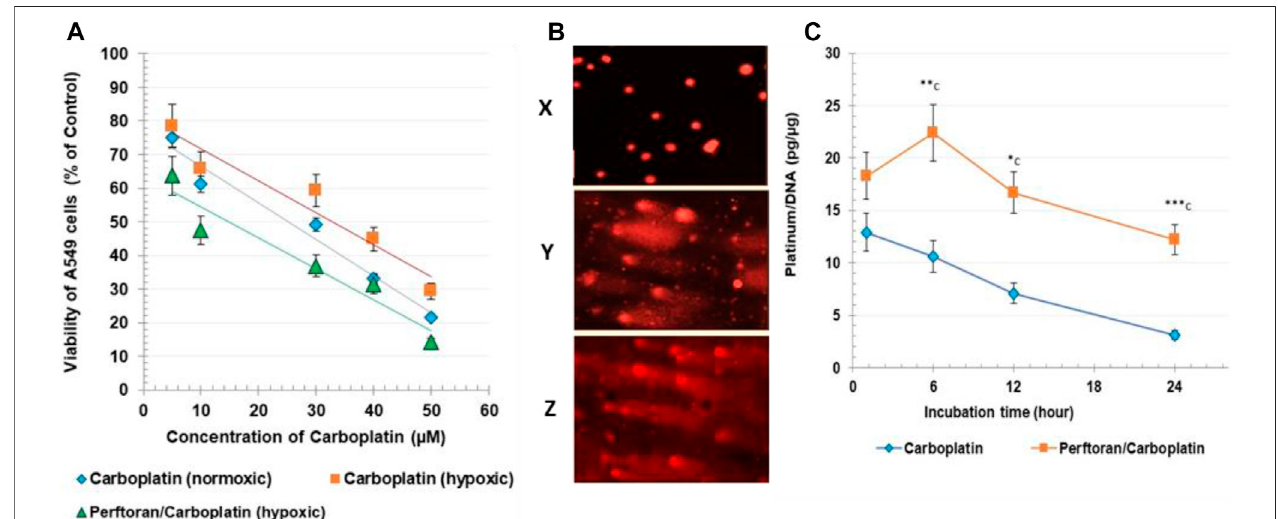
FIGURE 1 | (A) Cytotoxicity: the viability of A549, assayed via MTT test. Cell viability is expressed as % of corresponding control cells. (B) Comet assay: microscopicimagesofcometassayresults.Imageswerecapturedundera fl uorescentmicroscope(400×magni fi cation);representativephotosinclude x normoxiccells, y carboplatin-treated cells, and z Perftoran ® /carboplatin-treated cells. (C) . DNA platination: Carboplatin/DNA adducts were measured after 1, 6, 12, and 24 h of cell incubation with carboplatin (10 µM) with/without oxygenated Perftoran ® (5%), under hypoxic conditions. DNA concentration was evaluated at 260 nm. Platinum